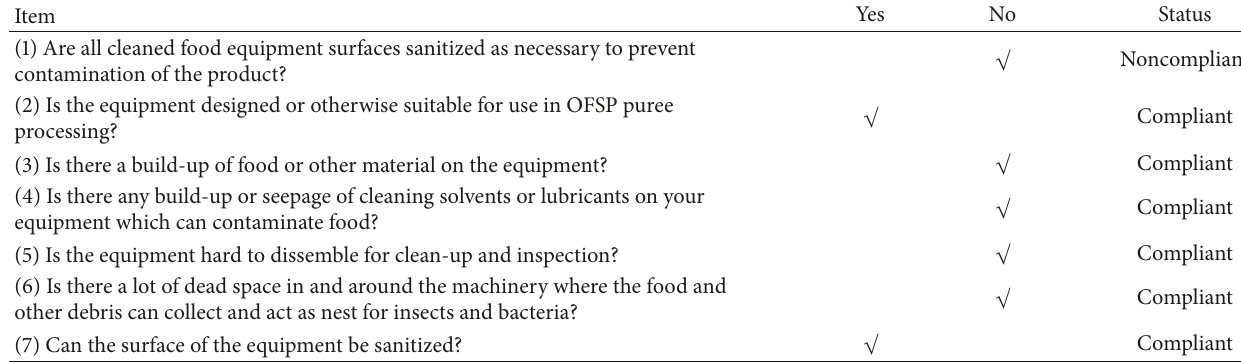
Table 1: Assessment of Good Manufacturing Practices for equipment used in OFSP puree processing.